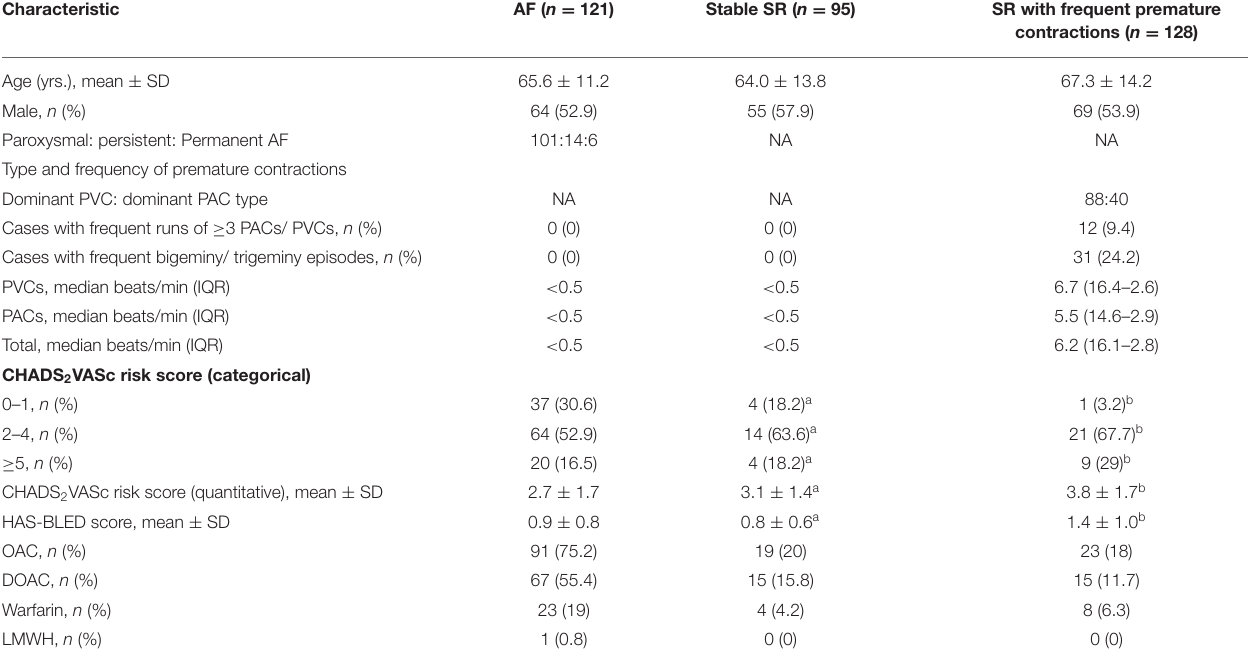
TABLE 1 | Baseline characteristics.